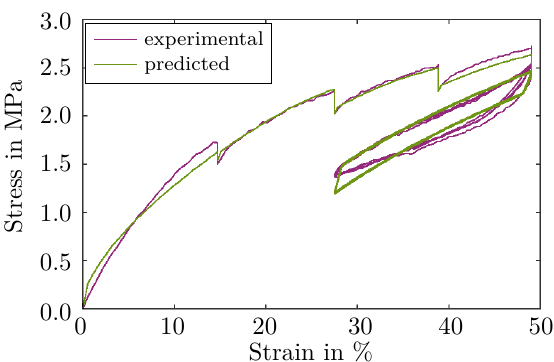
Figure 6. Experimental and predicted stress-strain diagram.